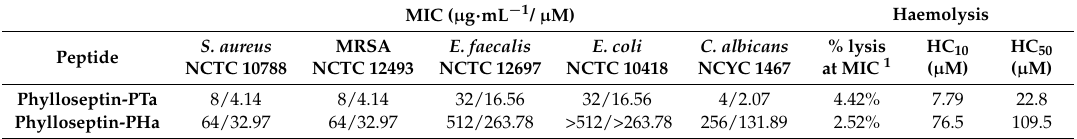
Table 2. Antimicrobial activity-minimum inhibitory concentration (MIC) determinations and haemolytic activity of purified synthetic phylloseptins. The half haemolytic concentration (HC 50 ) and 10% haemolytic concentration (HC 10 ) were analyse by Graphpad Prism Software (version 6.0).